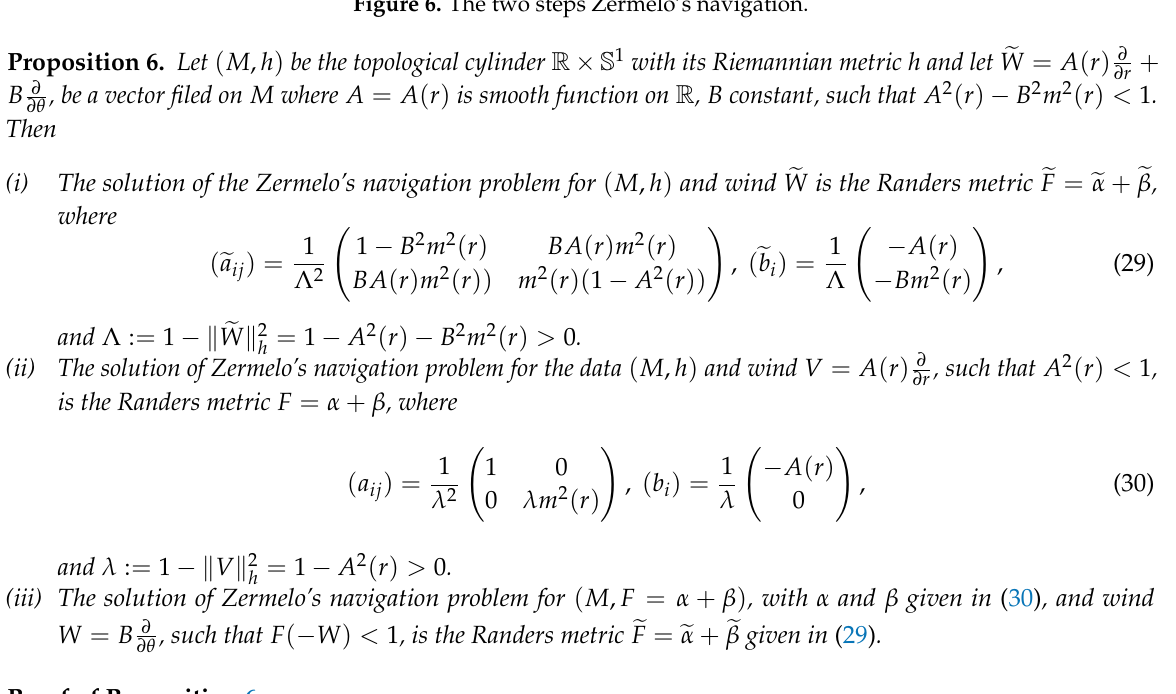
Figure 6. The two steps Zermelo’s